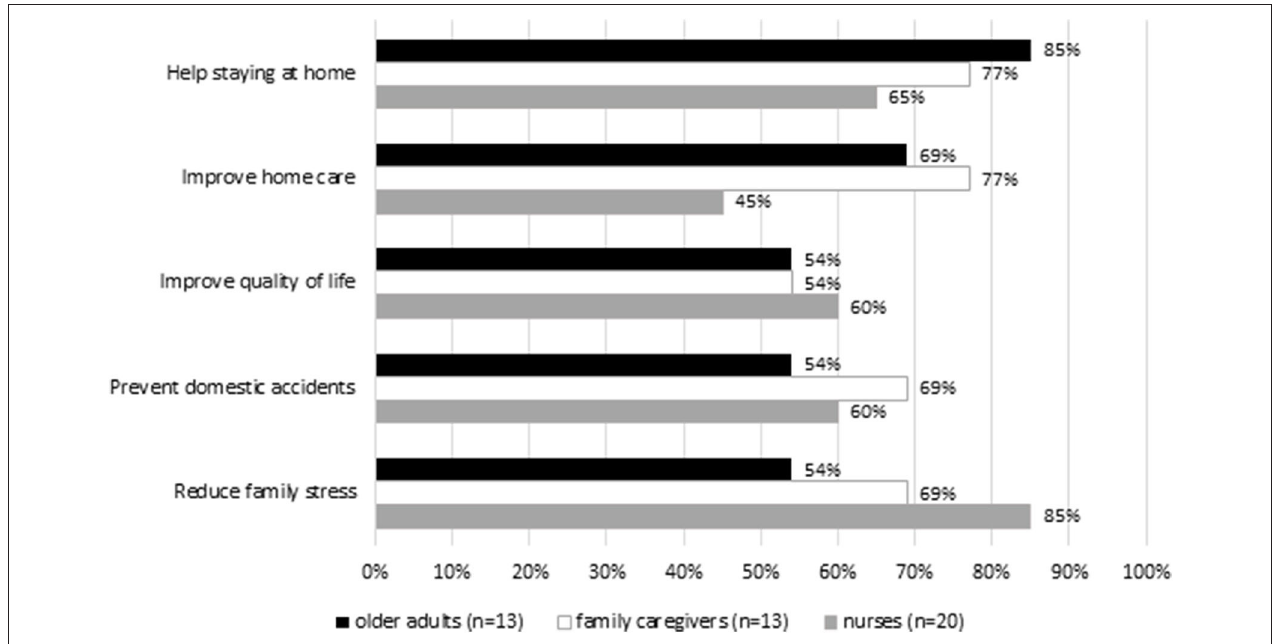
FIGURE 4 | Opinion on the wearable sensor (Activity